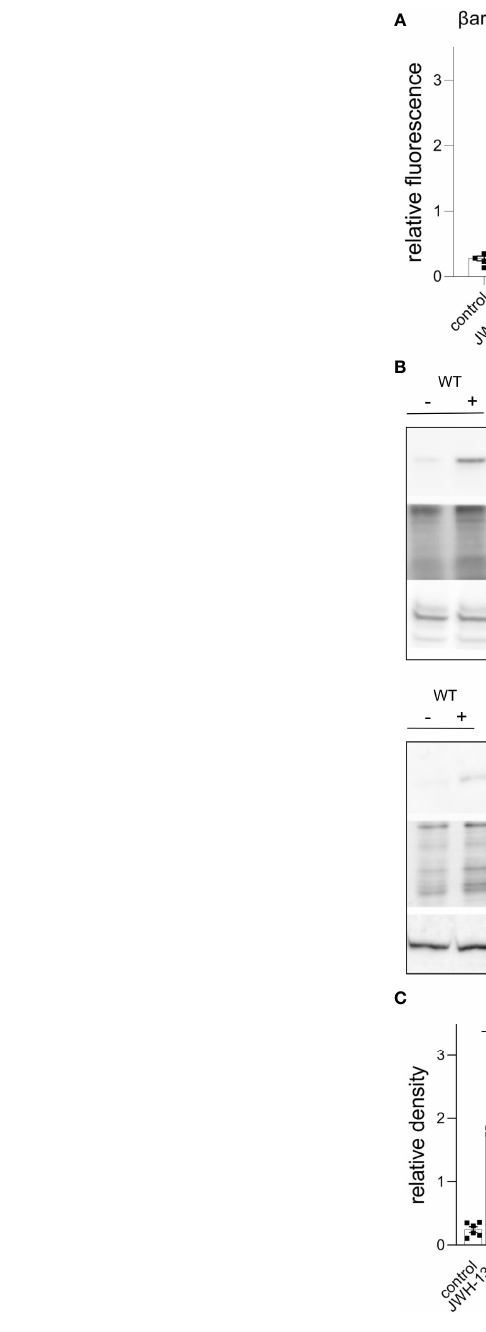
FIGURE 3 | Proximity biotinylation assays: HEK 293T cells were either co-transfected with plasmids encoding wild type or mutant CB 2 R – BirA and b -arrestin2 – Venus (A) or transfected only with BirA-tagged CB 2 Rs (B, C) . 24 h after the transfection, cells were stimulated with 10 m M JWH-133, and at the same time 100 m M biotin was added for 20 – 24 h (A) The cells were lysed and the biotinylated b -arrestin2 – Venus was pulled down using NeutrAvidin beads. Total Venus fl uorescence on the beads is shown ± S.E.M. Two-way ANOVA indicated signi fi cant effects on the variation of both the mutations and the stimulation (stimulation: p<0.001, mutation: p<0.01) (B – D) Interaction of CB 2 Rs with endogenous GRK2 and GRK3. Representative blots of pull-downs are shown on panel (B) . Quanti fi ed densities were normalized to streptavidin staining and data are shown as individual samples and mean ± S.E.M. (n=6-5) (C) . The results were analyzed by two-way ANOVA (stimulation and mutation) and Tukey ’ s post-hoc test was applied for pairwise comparisons of the wild-type and mutant CB 2 R. For both GRKs, two-way ANOVA indicated signi fi cant effects on the variation of both the mutations and the stimulation (stimulation: p<0.01 for both, mutation: p<0.001 for GRK2 and p<0.05 for GRK3, respectively). # indicates signi fi cant difference vs. mock-stimulated samples, * indicates a signi fi cant difference compared to L133I mutant and $ indicates a signi fi cant difference compared to Q63R in pairwise comparisons in the post-hoc test (p<0.05) (A, C)